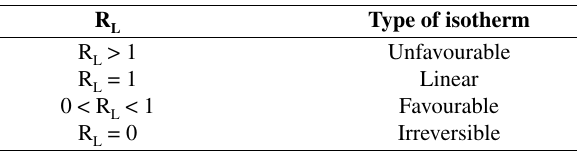
and type of isotherm: L